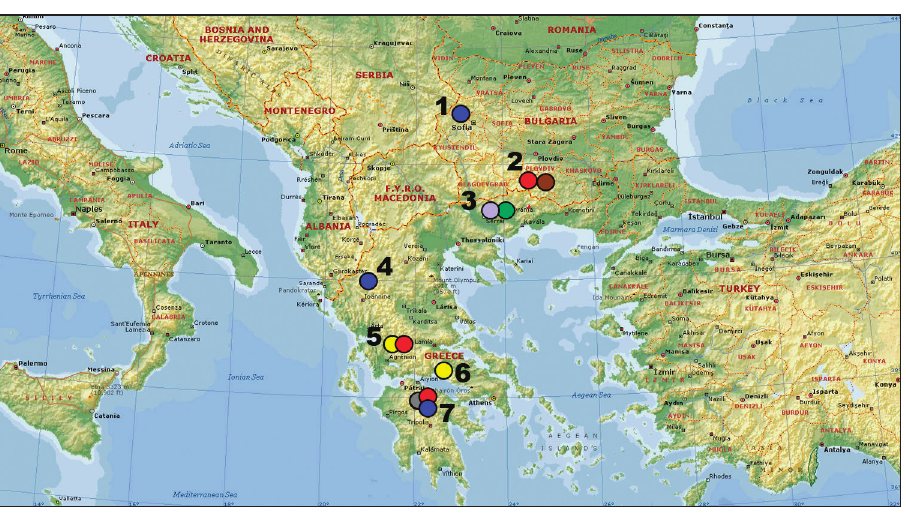
Figure 1. Localities of the species collected for the study (the species list is presented in Table 1). 1 Bul- garia: Dragoman ( P. admetus ) 2 Bulgaria: Hvoyna ( P. ripartii pelopi , P. orphicus orphicus ) 3 Greece: Granitis ( P. nephohiptamenos , P. orphicus eleniae ) 4 Greece: Smolikas ( P. admetus ) 5 Greece: Timfristos Mt ( P. ripar- tii pelopi , P. timfristos ) 6 Greece: Parnassos Mt ( P. timfristos ) 7 Greece: Kalavrita ( P. admetus , P. aroaniensis , P. ripartii pelopi ). Colored circles match different taxa. Blue circle: P. admetus . Red circle: P. ripartii . Brown circle: P. orphicus orphicus . Lavender circle: P. orphicus eleniae . Yellow circle: P. timfristos sp. n. Grey circle: P. aroaniensis